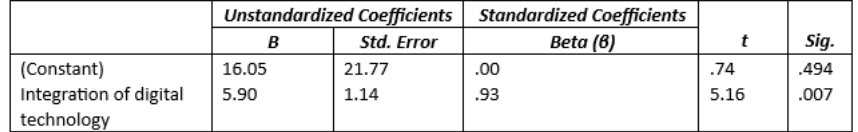
Figure 11. Linear regression: digitalization and labor productivity—Romania.